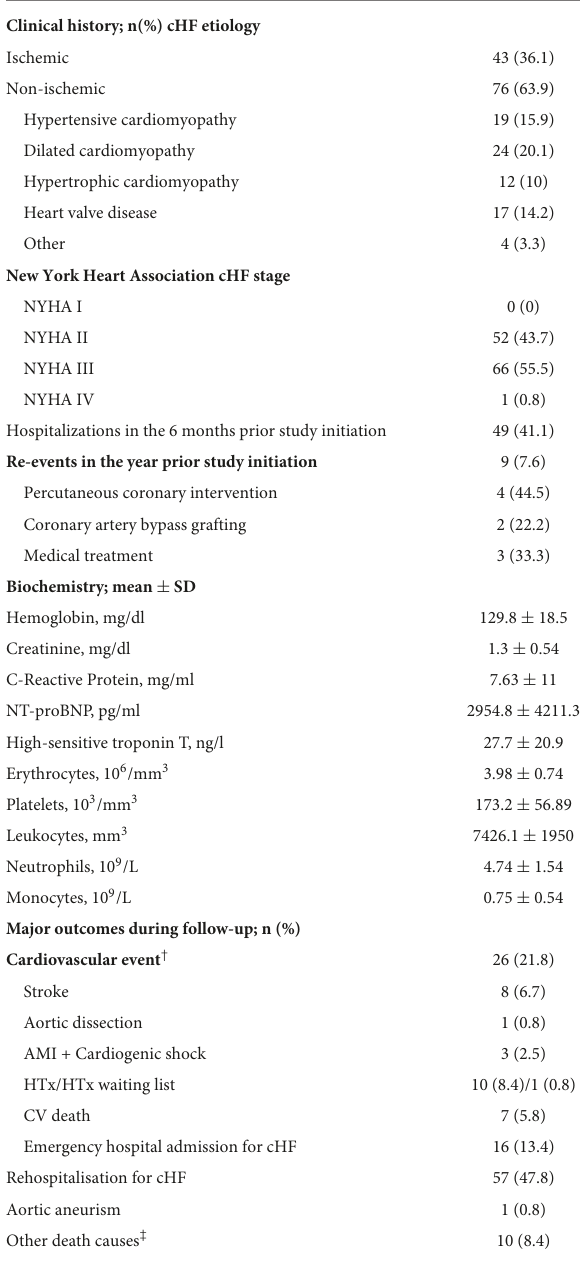
TABLE 2 Clinical characteristics of cHF patients at baseline ( n =